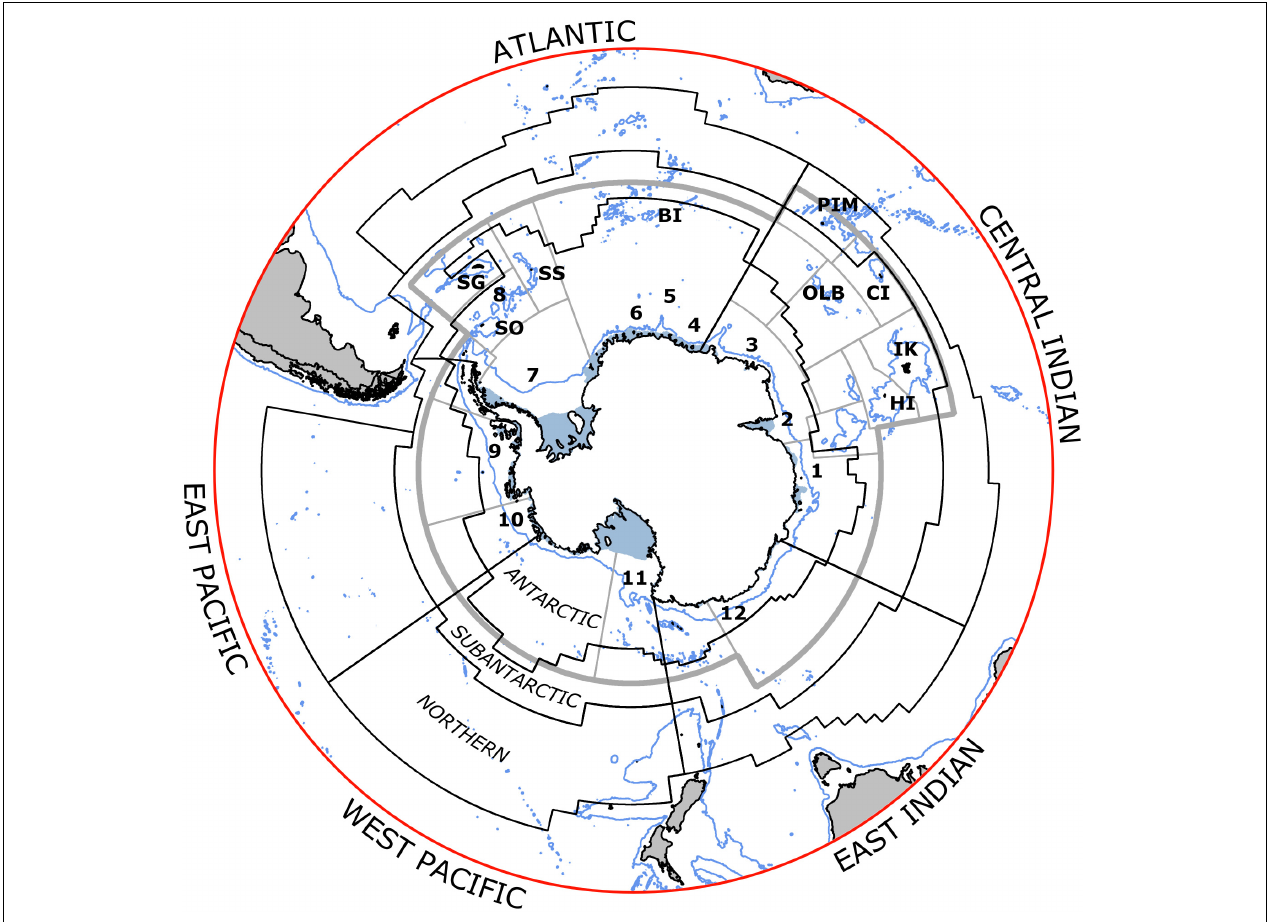
FIGURE 2 | Areas for assessing status and trends of local drivers in the Marine Ecosystem Assessment for the Southern Ocean (black lines). Sectors are divided meridionally: corresponding names of sectors are outside the circle. Zones extend from the coast to the Southern Antarctic Circumpolar Front (Antarctic), to the Subantarctic Front (Subantarctic) and to the Subtropical Front (Northern). Seas are marked in the Antarctic Zone as (1) Davis, (2) Cooperation, (3) Cosmonaut, (4) Riiser-Larsen, (5) Haakon VII, (6) Lazarev, (7) Weddell, (8) Scotia, (9) Bellingshausen, (10) Amundsen, (11) Ross, (12) Dumont D’Urville. Islands in the CCAMLR area include Heard (HI), Isle Kerguelen (IK), Crozet (CI), Prince Edward-Marion (PEM), Bouvet (BI), South Sandwich (SS), South Georgia (SG), South Orkney (SO), Ob and Lena Banks (OLB), and South Shetlands (not initialled but found on the north-western side of Antarctic Peninsula). Grey lines indicate the CCAMLR reporting areas (Subareas and